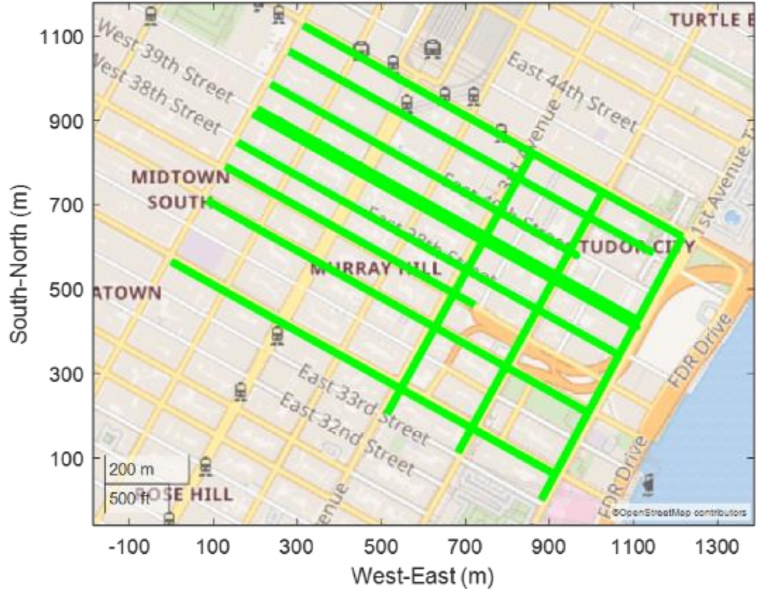
Figure A1. Map plot of a total of 11 experimental navigation trips in New York, each straight green line represents one trip,